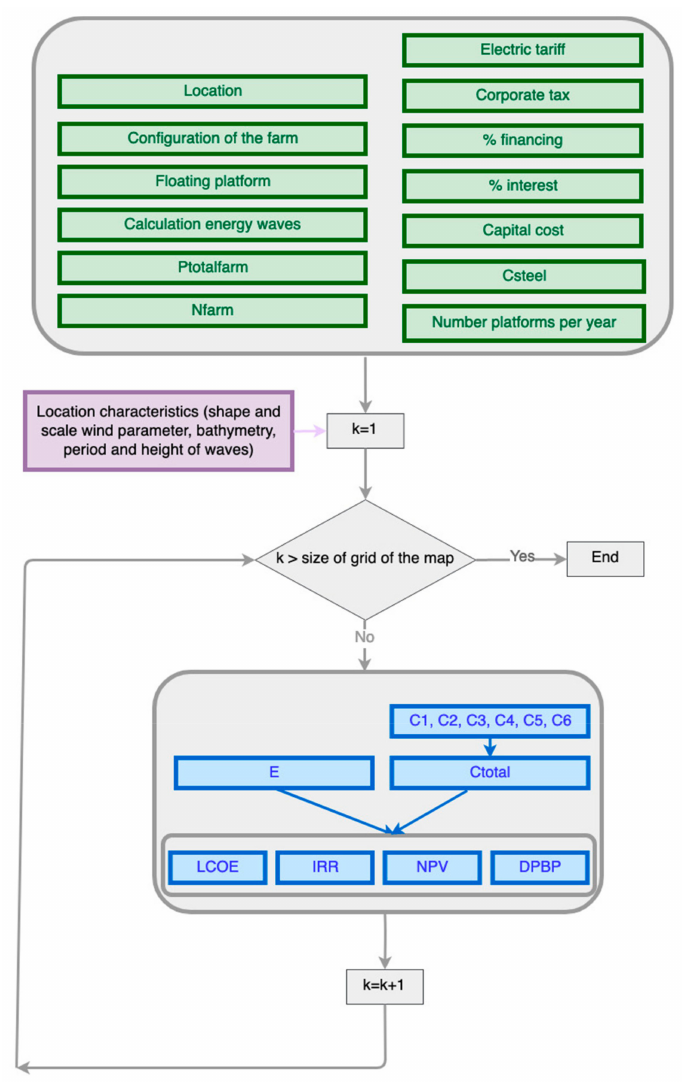
Figure 2. Flow diagram of the software. Input variables being the following: the total power of the farm (Ptotalfarm), number of years of the life-cycle (Nfarm), cost of steel (Csteel), the number of points that the input maps have (k), energy produced (E), total cost of the farm (Ctotal), defining cost (C1), designing and developing cost (C2), manufacturing cost (C3), installing cost (C4), exploiting cost (C5), and dismantling cost